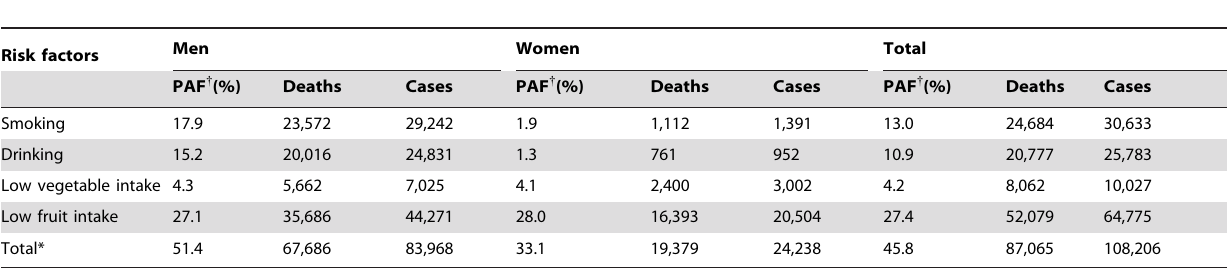
Table 2. Esophageal cancer deaths and cases attributable to smoking, drinking, low vegetable intake and low fruit intake in China in 2005.